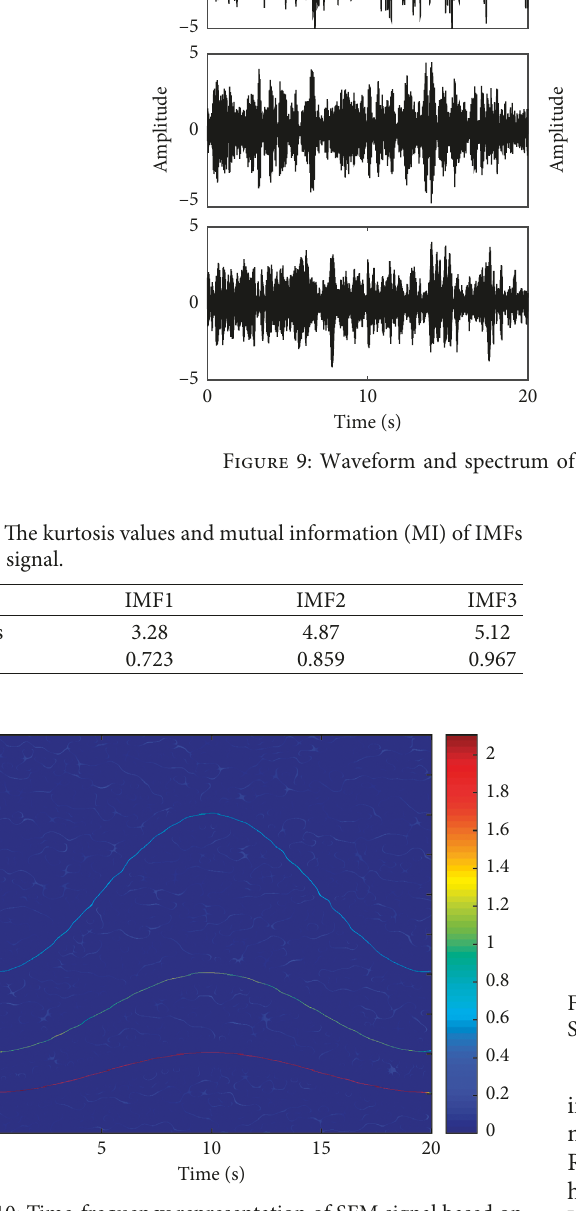
Figure 10: Time-frequency representation of SFM signal based on VMD-SET.